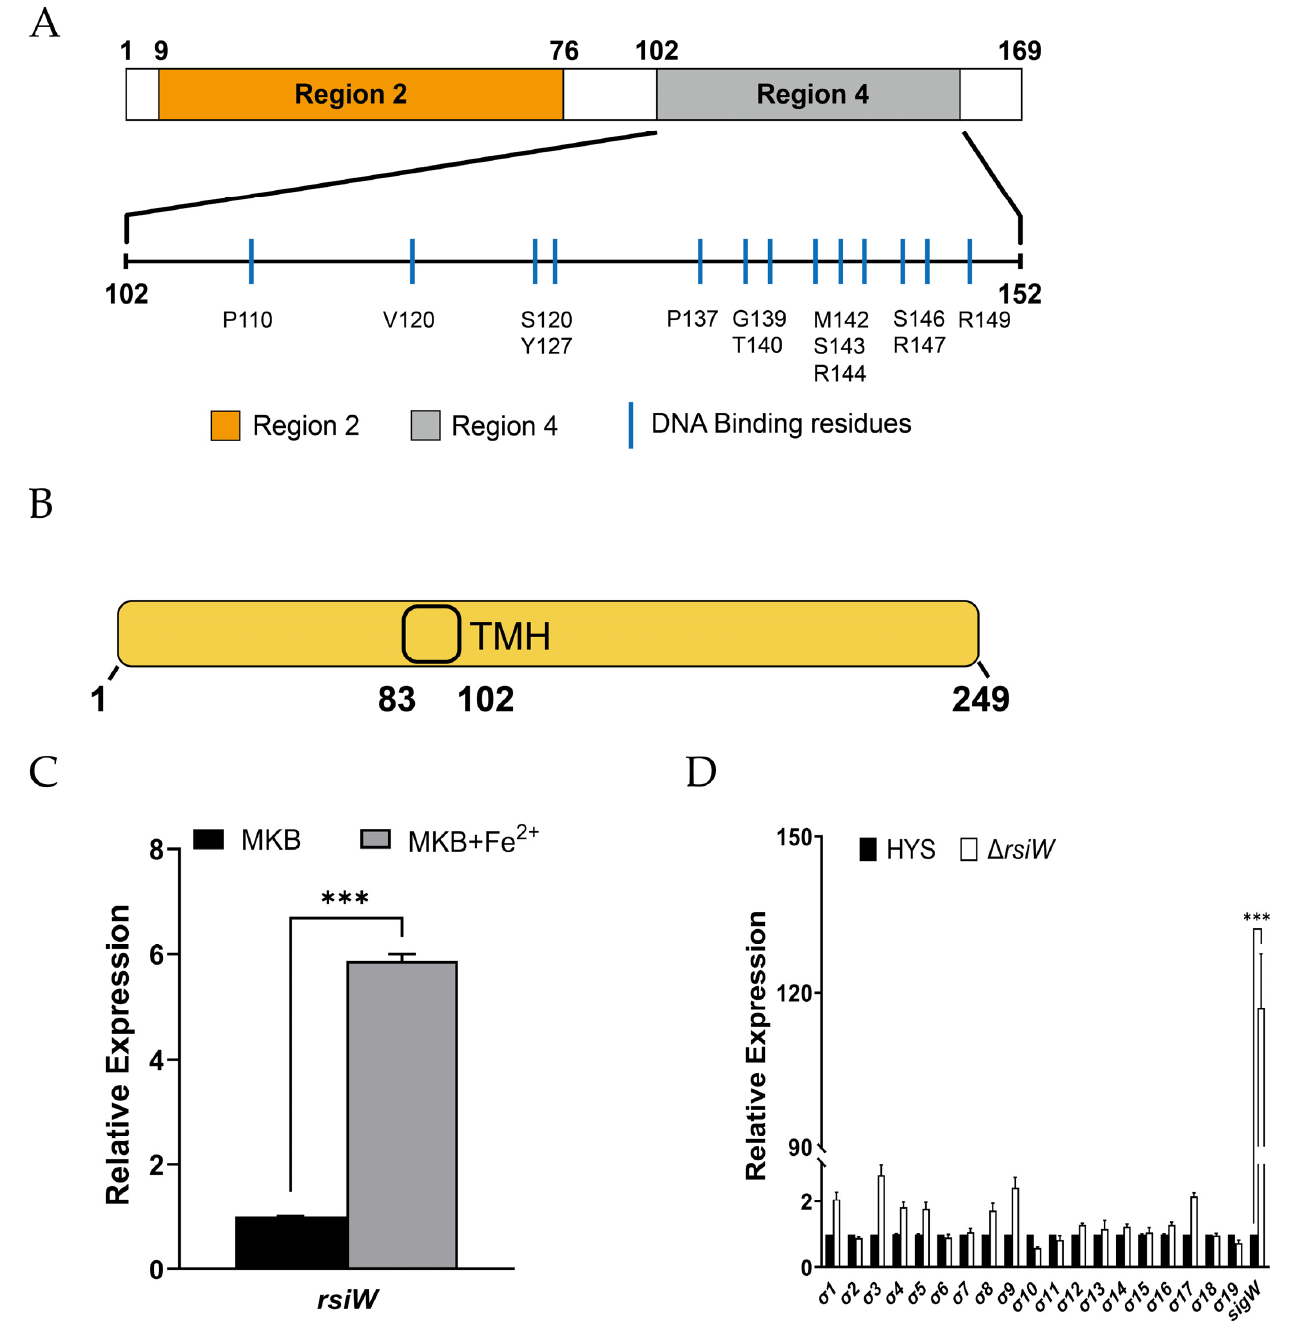
Figure 2. RsiW functions as the anti- σ factor of SigW in P. donghuensis HYS. The domain architectures are illustrated, along with their structures. The region 2 and region 4 domains usually carried by ECF σ factors are shown. The blue lines represent DNA binding sites with the corresponding amino acid indicated below ( A ). The transmembrane helices (TMH) in RsiW were predicted by the transmembrane protein topology prediction tool TMHMM ( B ). ( C ) Expression of the anti- σ factor, rsiW in different extracellular iron environments. MKB simulates an iron-limited environment and MKB supplement 30 μ M ferrous ions simulates an iron-rich environment. ( D ) The relative expression of 20 ECF σ factors in the wild-type strain of P. donghuensis HYS and Δ rsiW mutant under the iron-limited conditions. RNA was isolated from the indicated strains grown to the exponential phase at 30 °C in liquid MKB culture with or without 30 μ M FeSO 4 ·7H 2 O supplementation. The error bars indicate the mean ± SD of three independent experiments.